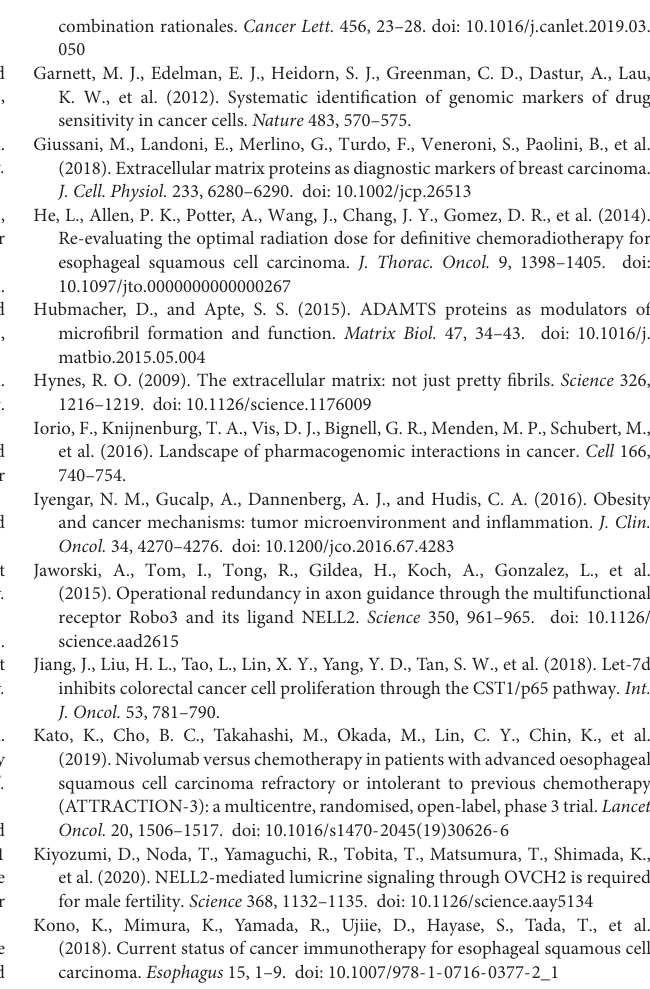
Supplementary Figure 1 | The prognostic values of four genes in patients with ESCC. (A) CST1, (B) NELL2, (C) ADAMTSL4, and (D)